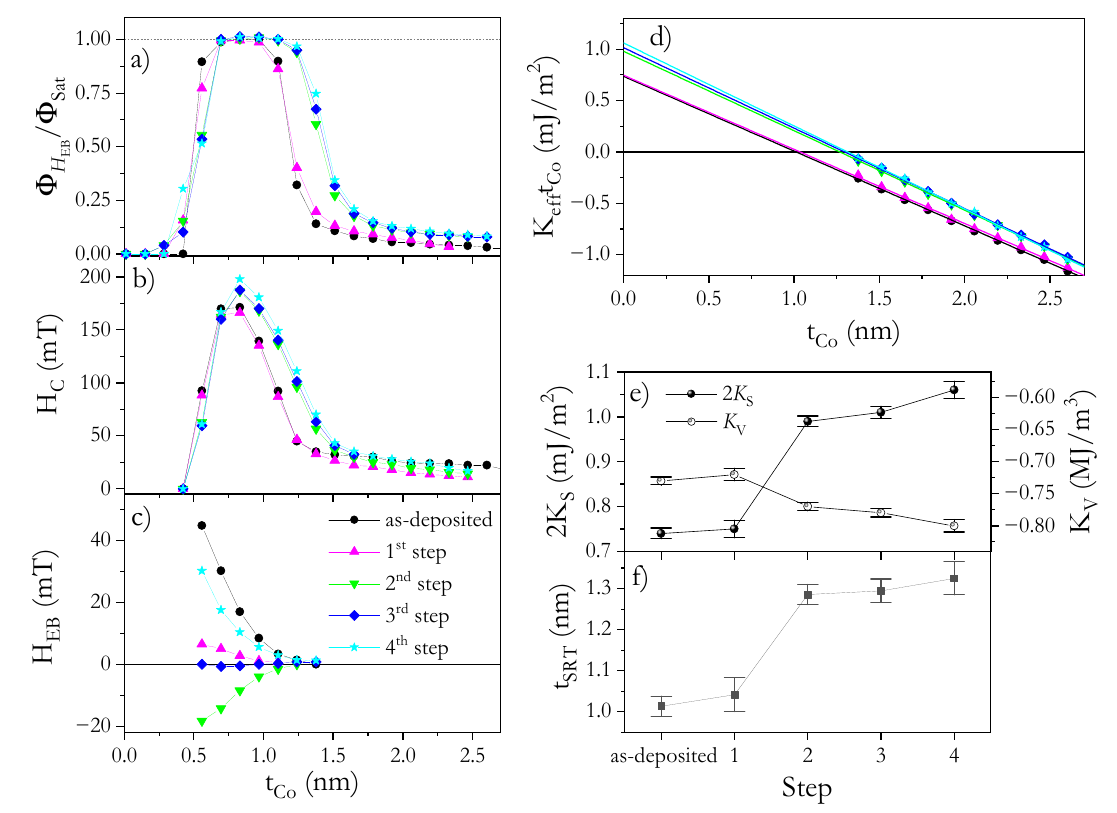
Figure 6. Normalized Kerr signal ( / ) at H = H EB ( a ), coercivity ( H C ) ( b ) and exchange bias field ( H EB ) ( c ) as functions of Co layer thickness for NiO b /Co/NiO t . Product of effective magnetic anisotropy and Co thickness ( K eff t Co ) as a function of t Co ( d ) for NiO b /Co/NiO t in the as-deposited state and after different FC steps. Volume and surface anisotropy constants (e) and SRT thickness ( f ) for NiO b /Co/NiO t in the as-deposited state and after four different FC steps (1st—350 K, +170 mT; 2nd—450 K, +170 mT; 3rd—350 K, − 170 mT; 4th—450 K, − 170 mT).